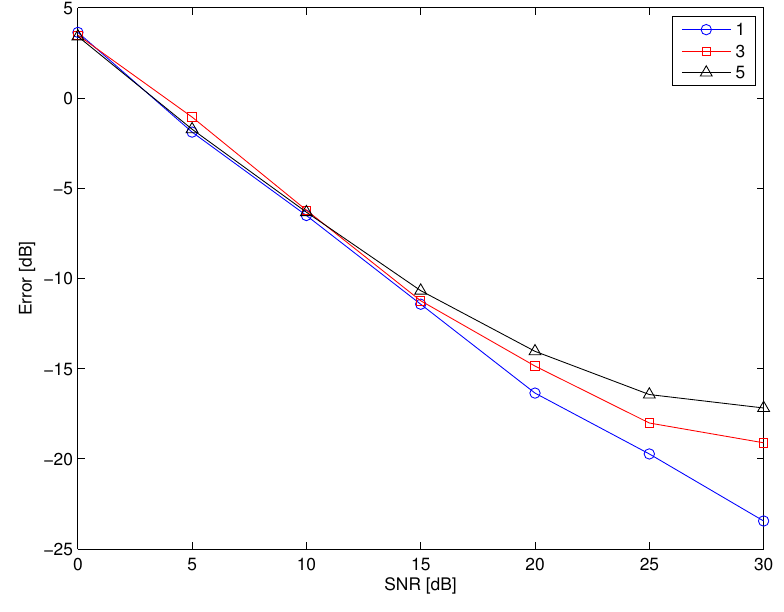
Figure 4. Error (dB) of the singular values estimation versus the SNR in the case of 90 scatterers (average value on 50 trials); 1, 3 and 5 lost elements; measured data affected by the 20-dB noise